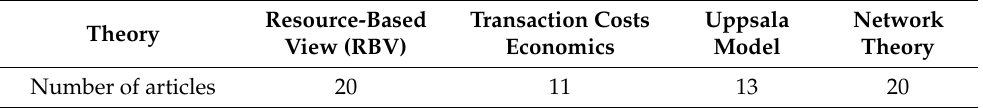
Table 2. Internationalization theories.